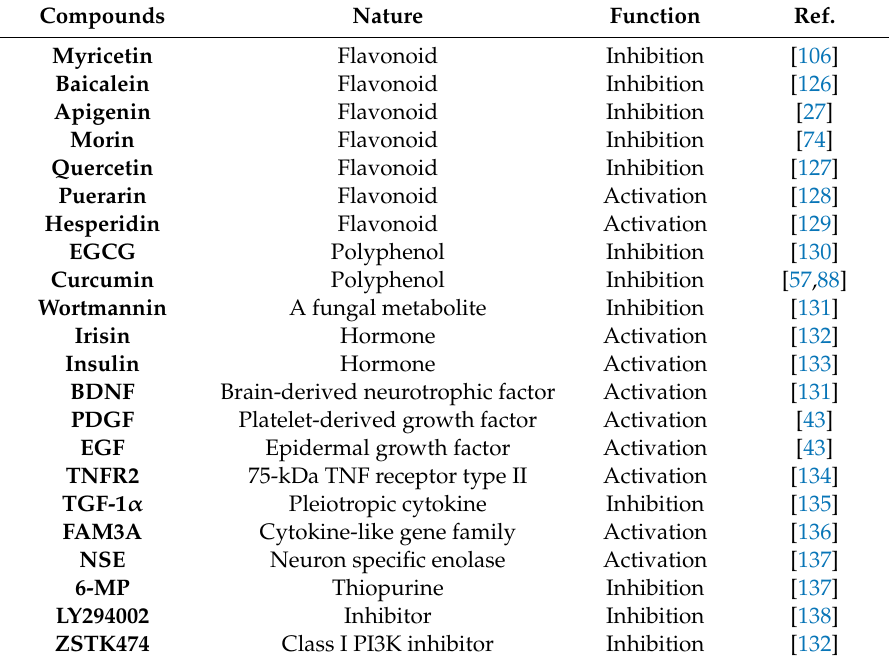
Table 2. Compounds involved in the activation / inhibition of the PI3K